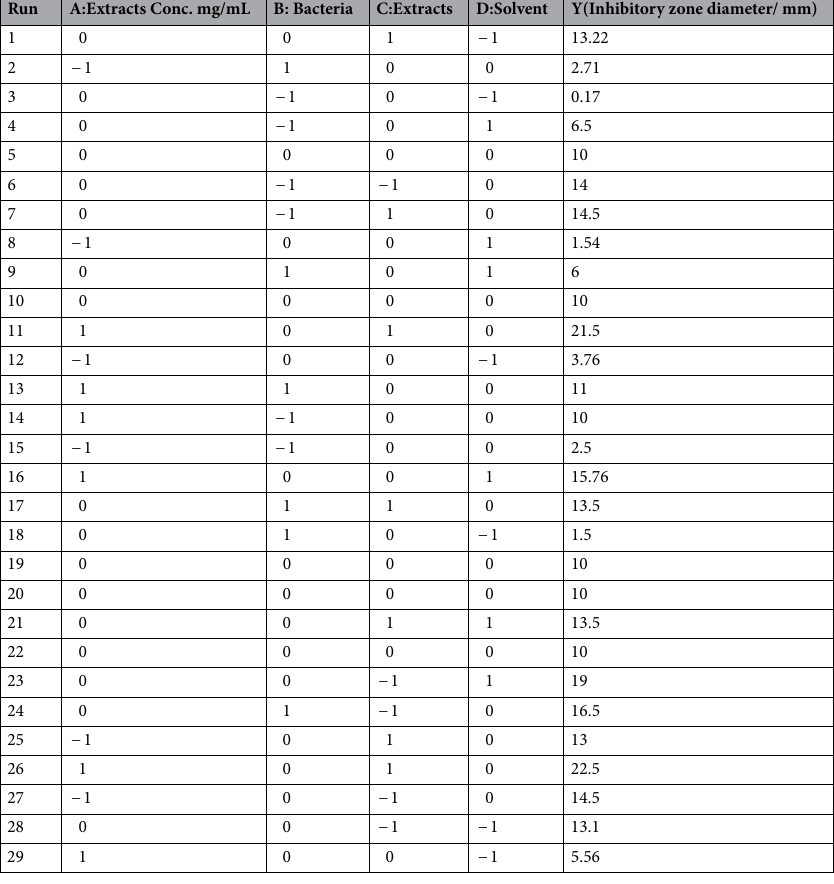
Table 3. Box—Behnken design with RSM